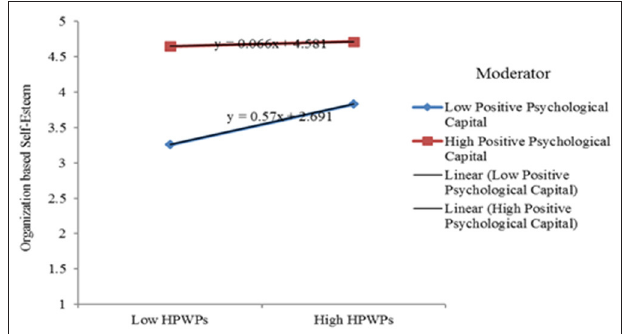
FIGURE 2 | Interaction